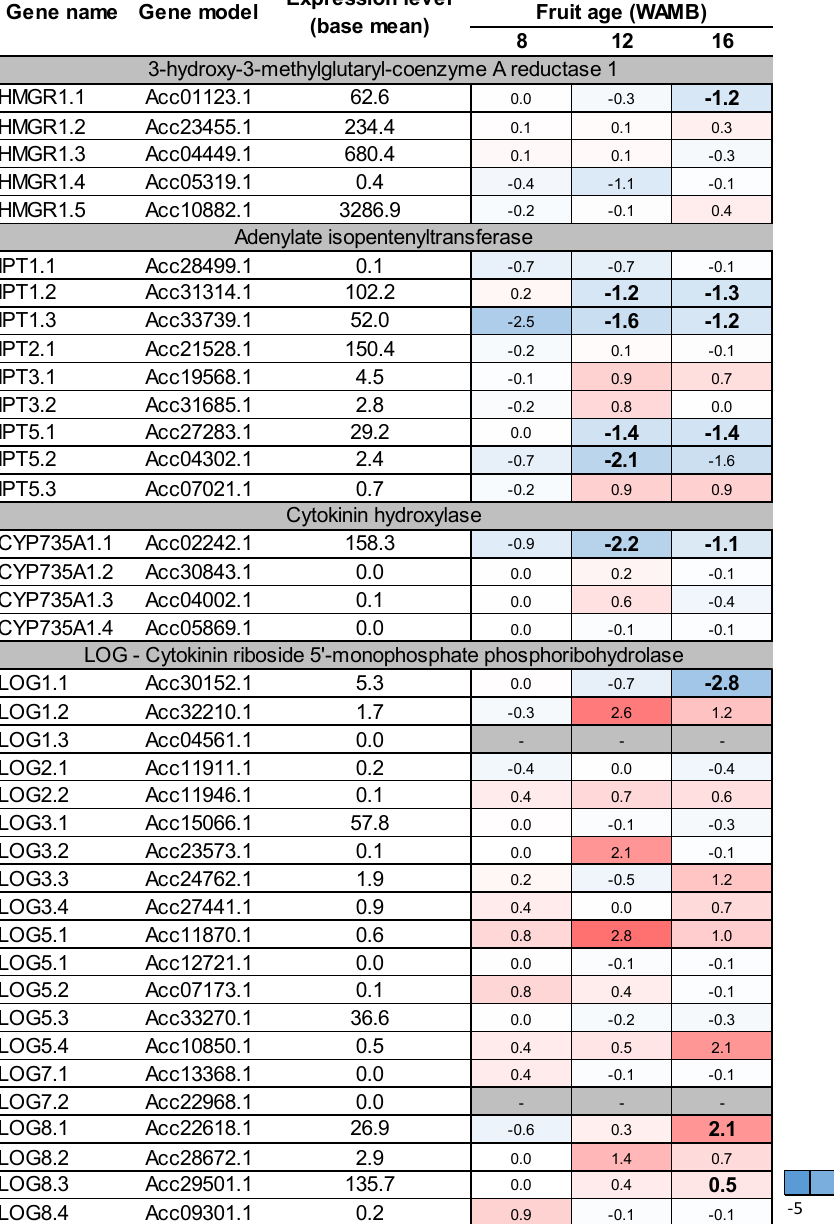
Figure 6. Heat-map of kiwifruit cytokinin biosynthetic genes. DESeq comparison of low carbohydrate supply (carbon starvation) versus high carbohydrate supply treatments. Differentially expressed genes were identified based on the DESeq analysis from Nardozza et al. [6]. For each gene, the expression level (base mean) and the log2 fold-change are presented. Fruit age is in weeks after mid bloom (WAMB). Bold figures mean differences are significant for adjusted p < 0.05 (DESeq analysis).